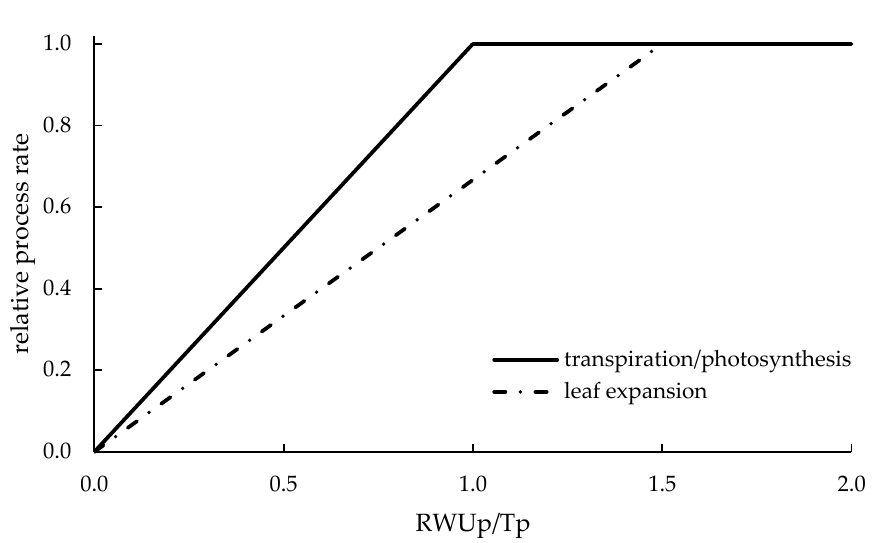
Figure 6. WS coefficients for vegetative growth initially developed for DSSAT (redrawn from Ritchie [51]). The stress is calculated on the ratio between potential root water uptake and potential transpiration. Transpiration and photosynthesis are affected when RWUp/Tp drops below 1, leaf expansion is affected when RWUp/Tp drops below 1.5, to account for the greater sensitivity of this process.